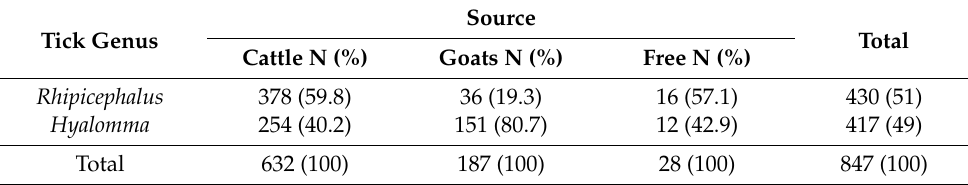
Table 3. Number (N) of ticks collected from cattle, goats, and environment (free) c